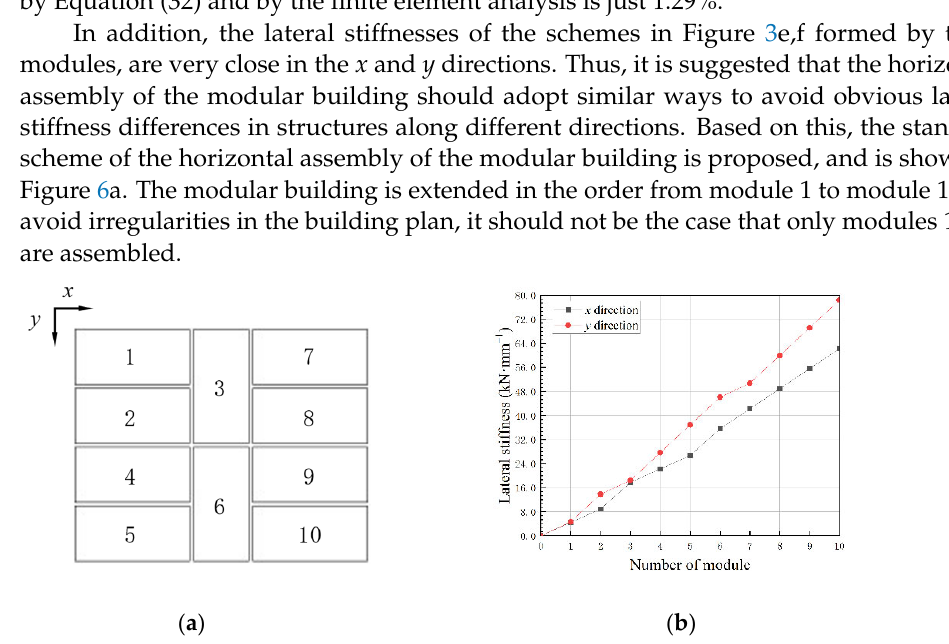
Figure 6. ( a ) A standard scheme of horizontal assembly and ( b ) Lateral stiffness of the structure. The lateral stiffness of the structure along the x and y directions in the standard scheme of horizontal assembly of the modular building with different module assembly numbers was investigated and is shown in Figure 6b.